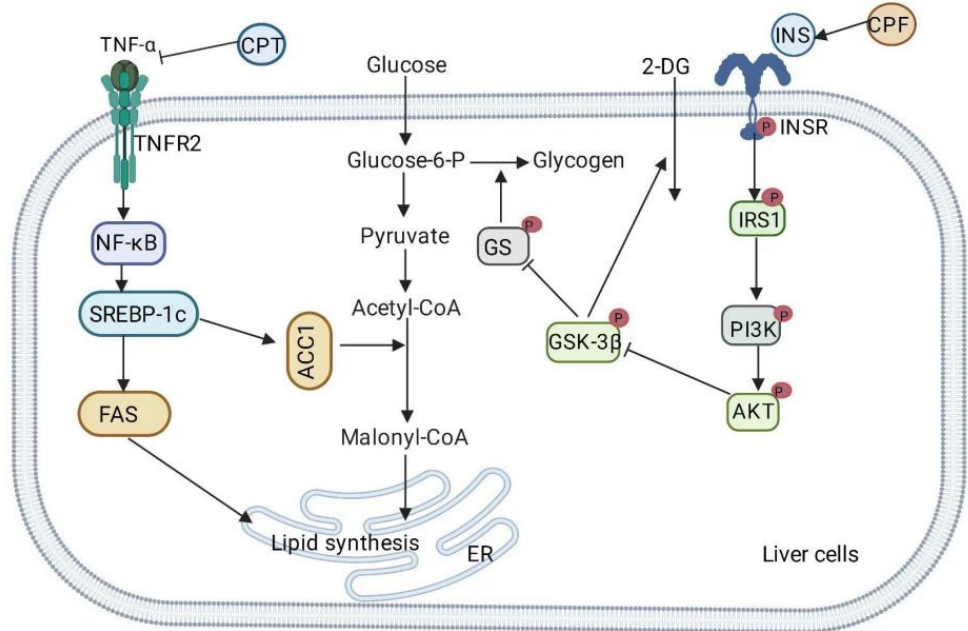
Figure 3. The mechanism of action of Cyclocarya paliurus extract with respect to inhibiting lipid synthesis and alleviating pathological insulin resistance in liver cells.